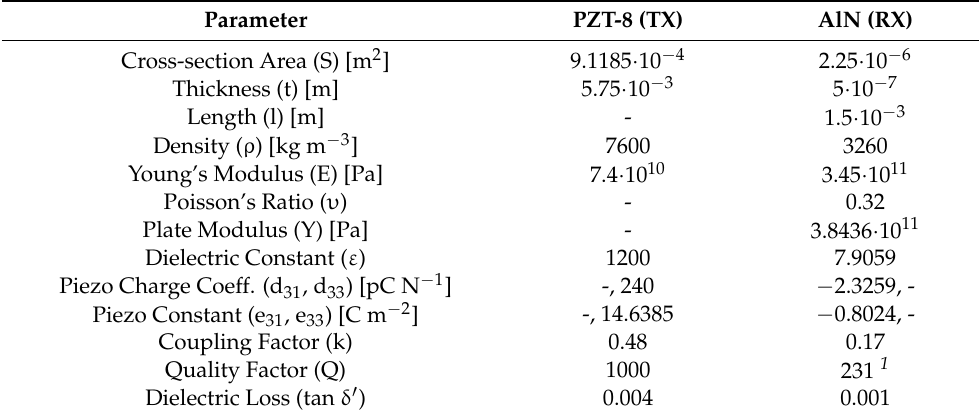
Table 1. Values of parameters characterizing the piezoelectric material in both TX and